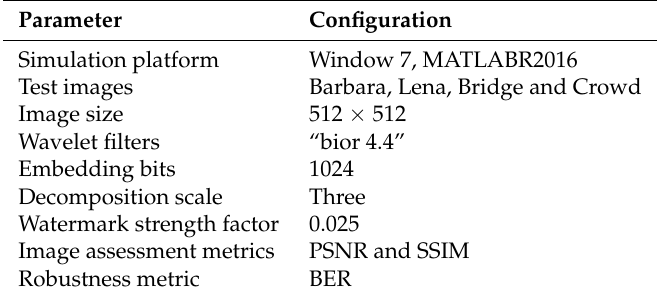
Table 4. Configuration of the simulation parameters.